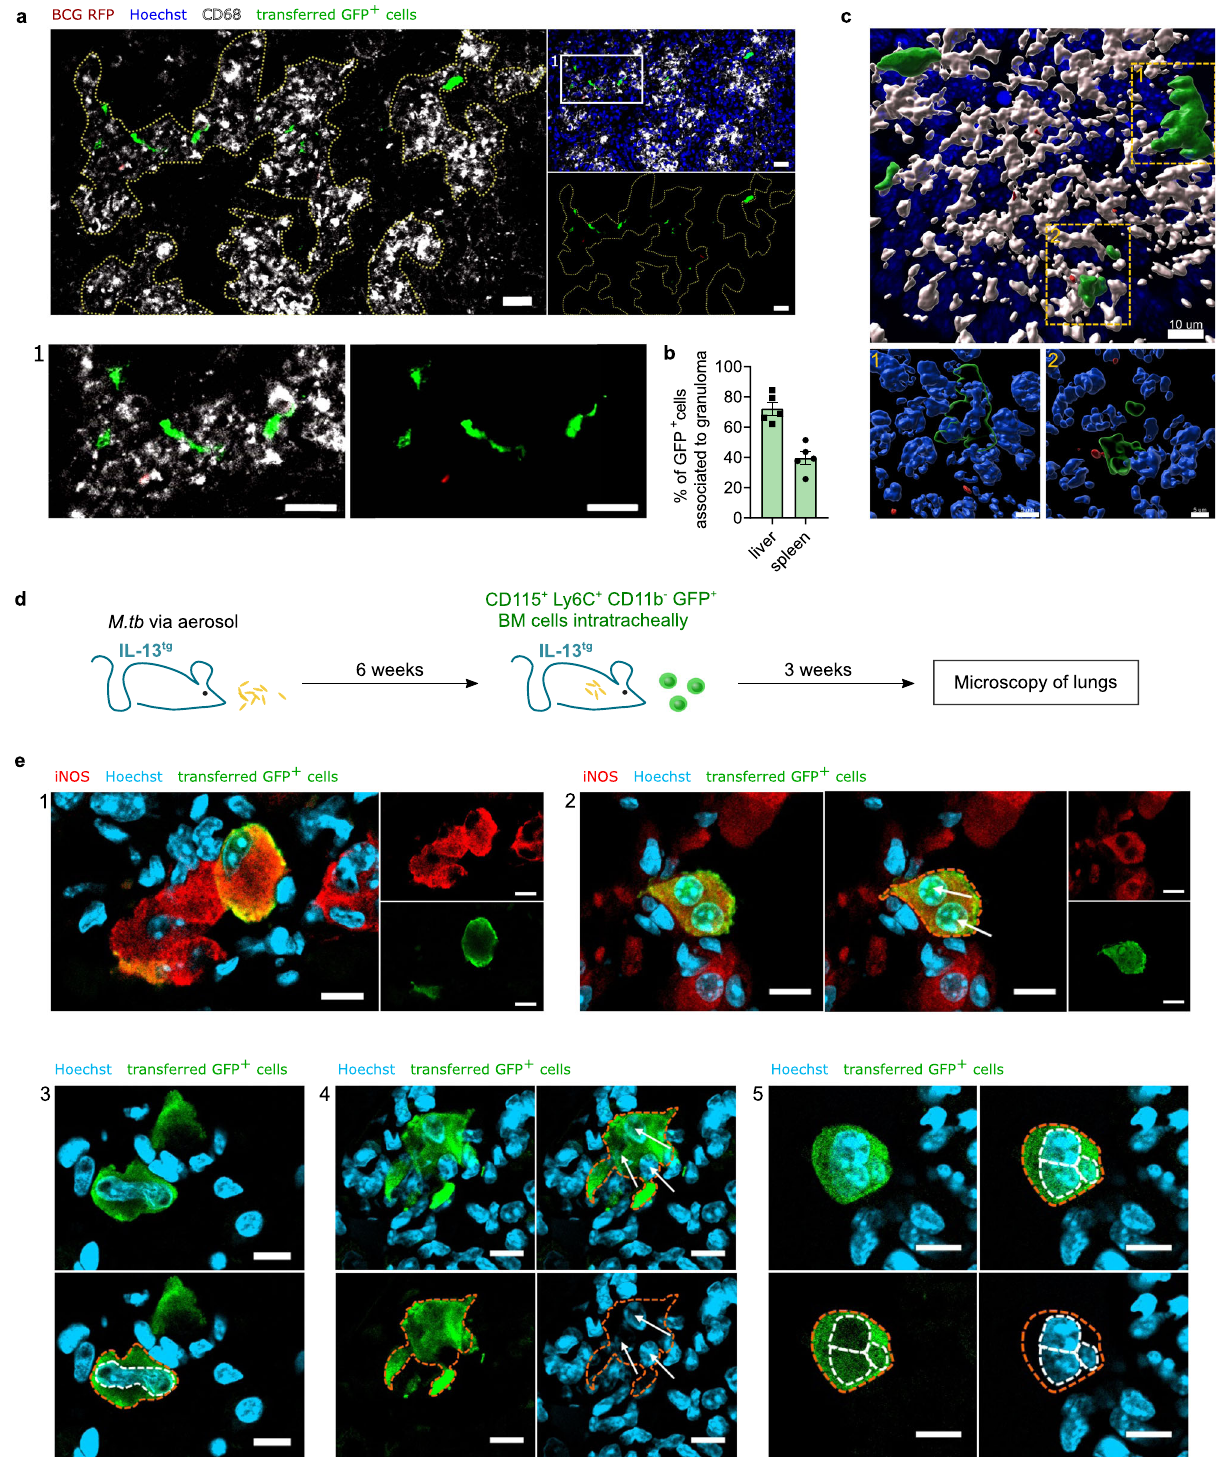
the fi ndings of Tornack et al. 61 who detected M.tb DNA in per- ipheral blood and hematopoietic stem cells of humans during latent Tb infection, the accumulation of lipids in progenitor cells might also provide a suitable environment for mycobacteria. Moreover, it is conceivable that monocyte progenitors may serve as Trojan horses for mycobacteria contributing to Tb